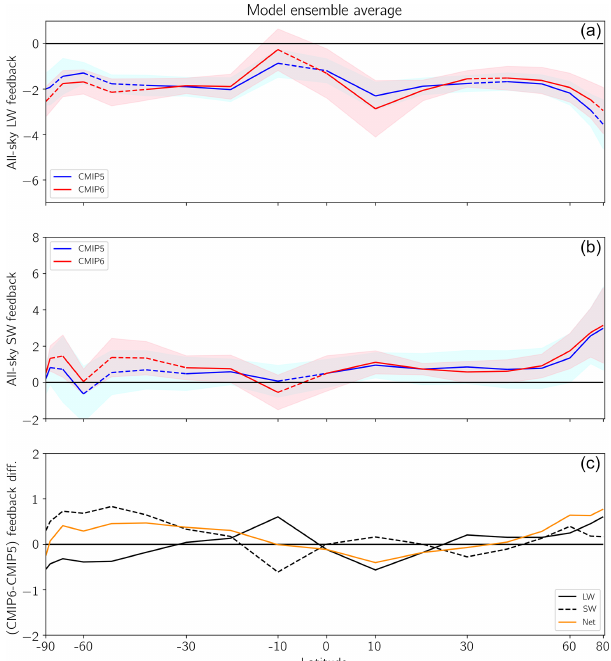
Figure 5. All-sky zonal average λ LW (a) and λ SW (b) for the CMIP5 ensemble average (blue) and CMIP6 ensemble (red). Dashed blue and red lines indicate regions where the difference in mean feedback is statistically significant ( p < 0 . 05). Light blue and red shading represent SD of each ensemble. Panel (c) displays the difference between the CMIP6 and CMIP5 ensemble average SW, LW, and net feedbacks as a function of